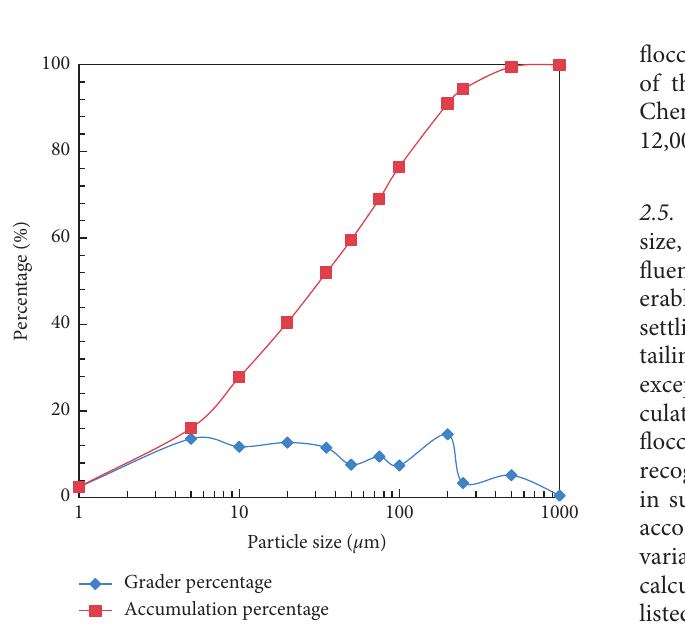
Figure 1: Particle size distribution curve of tailings.